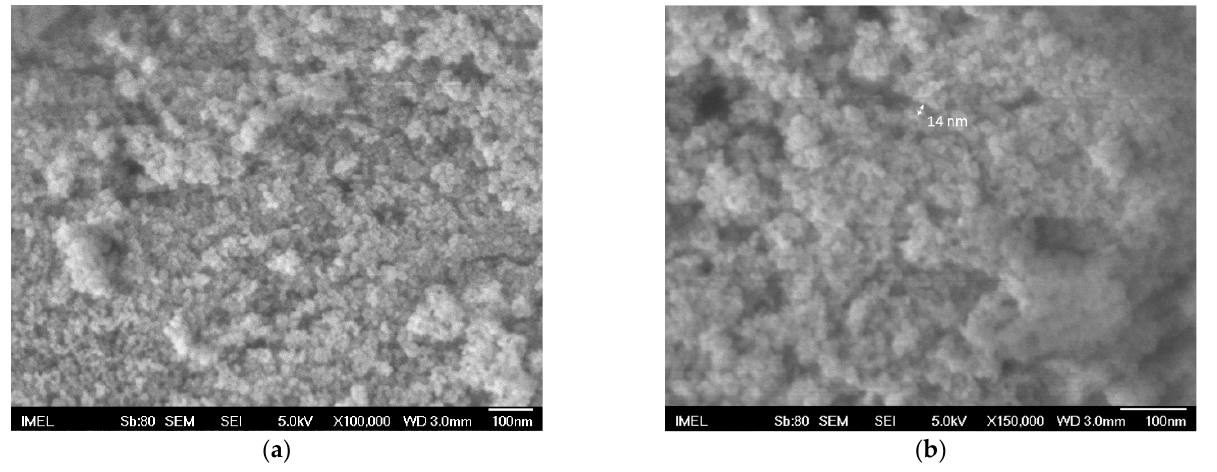
Figure 6. FESEM analysis on N-doped TiO 2 powder in ( a ) ×100,000 and ( b ) ×150,000 magnification.